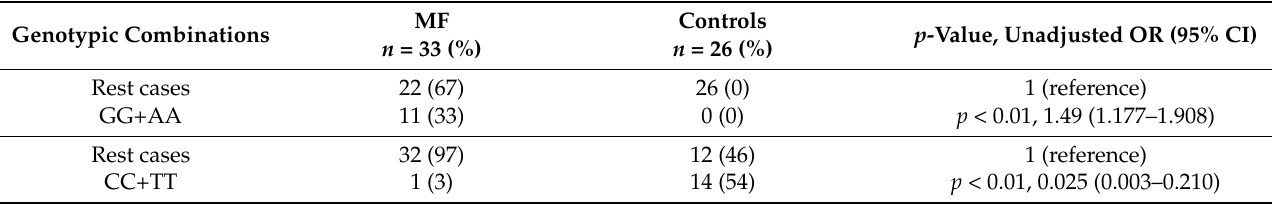
Table 3. Distribution of genotypic combinations of rs2910164 and rs767649 in MF patients and con-